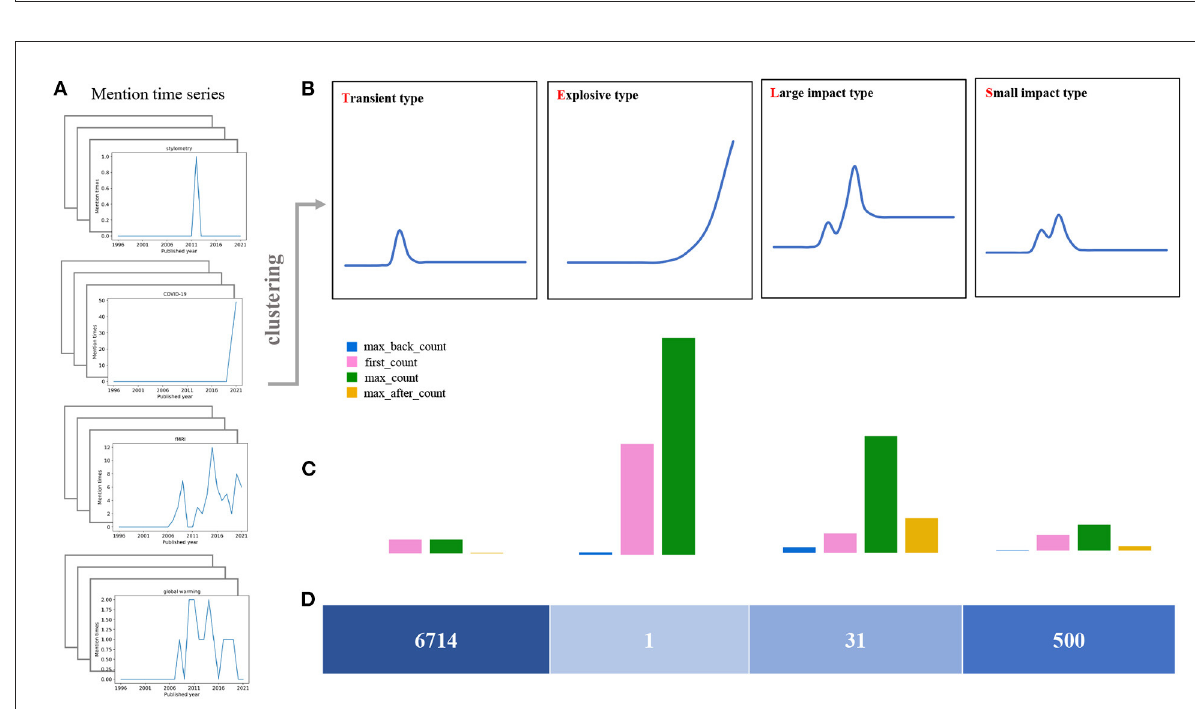
FIGURE3 Data mapping. (A) Minimize the SSE and use the elbow method to select the optimal number of clusters k algorithm to divide 7,246 keywords into four clusters, and the data is projected into a low-dimensional space using LDA. The LDA algorithm is a dimensionality reduction technique for supervised learning, which is based on the smallest intra-class variance and the largest inter-class variance after projection. (B) Subsequently, keywords with high frequencies in each cluster are used to represent the cluster.